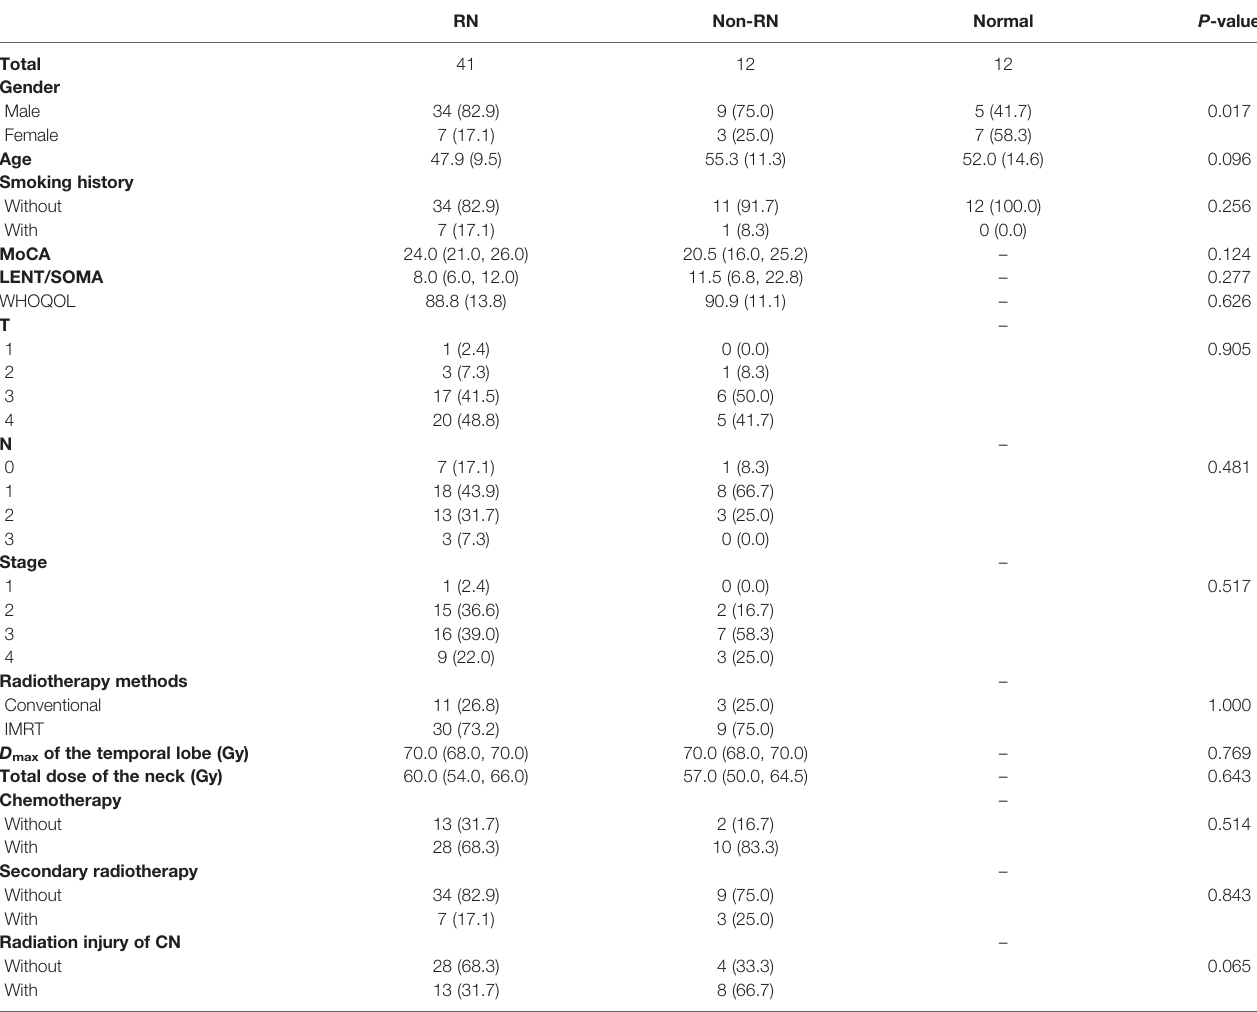
TABLE 1 | Baseline comparison of the RN, non-RN, and normal